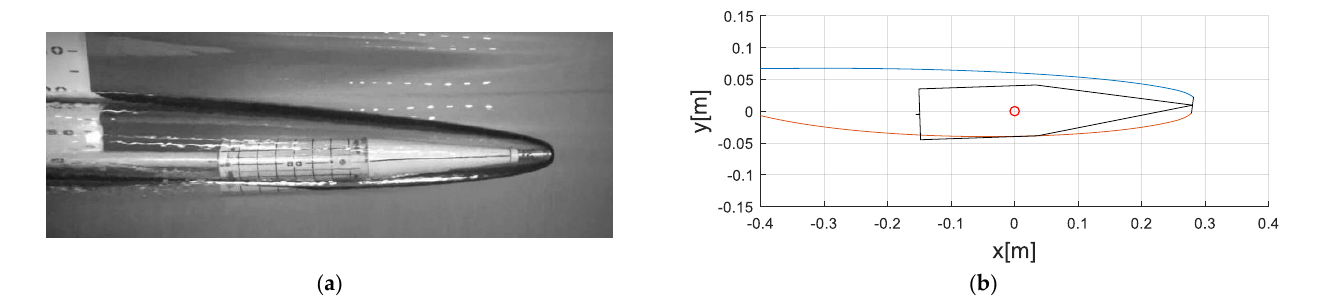
Figure 9. Experimental and calculated trim conditions in a steady planing mode (disk-type cavitator. V = 9.12 m/s, 𝜎 = 0.064) : ( a ) experiment; ( b ) calculation.